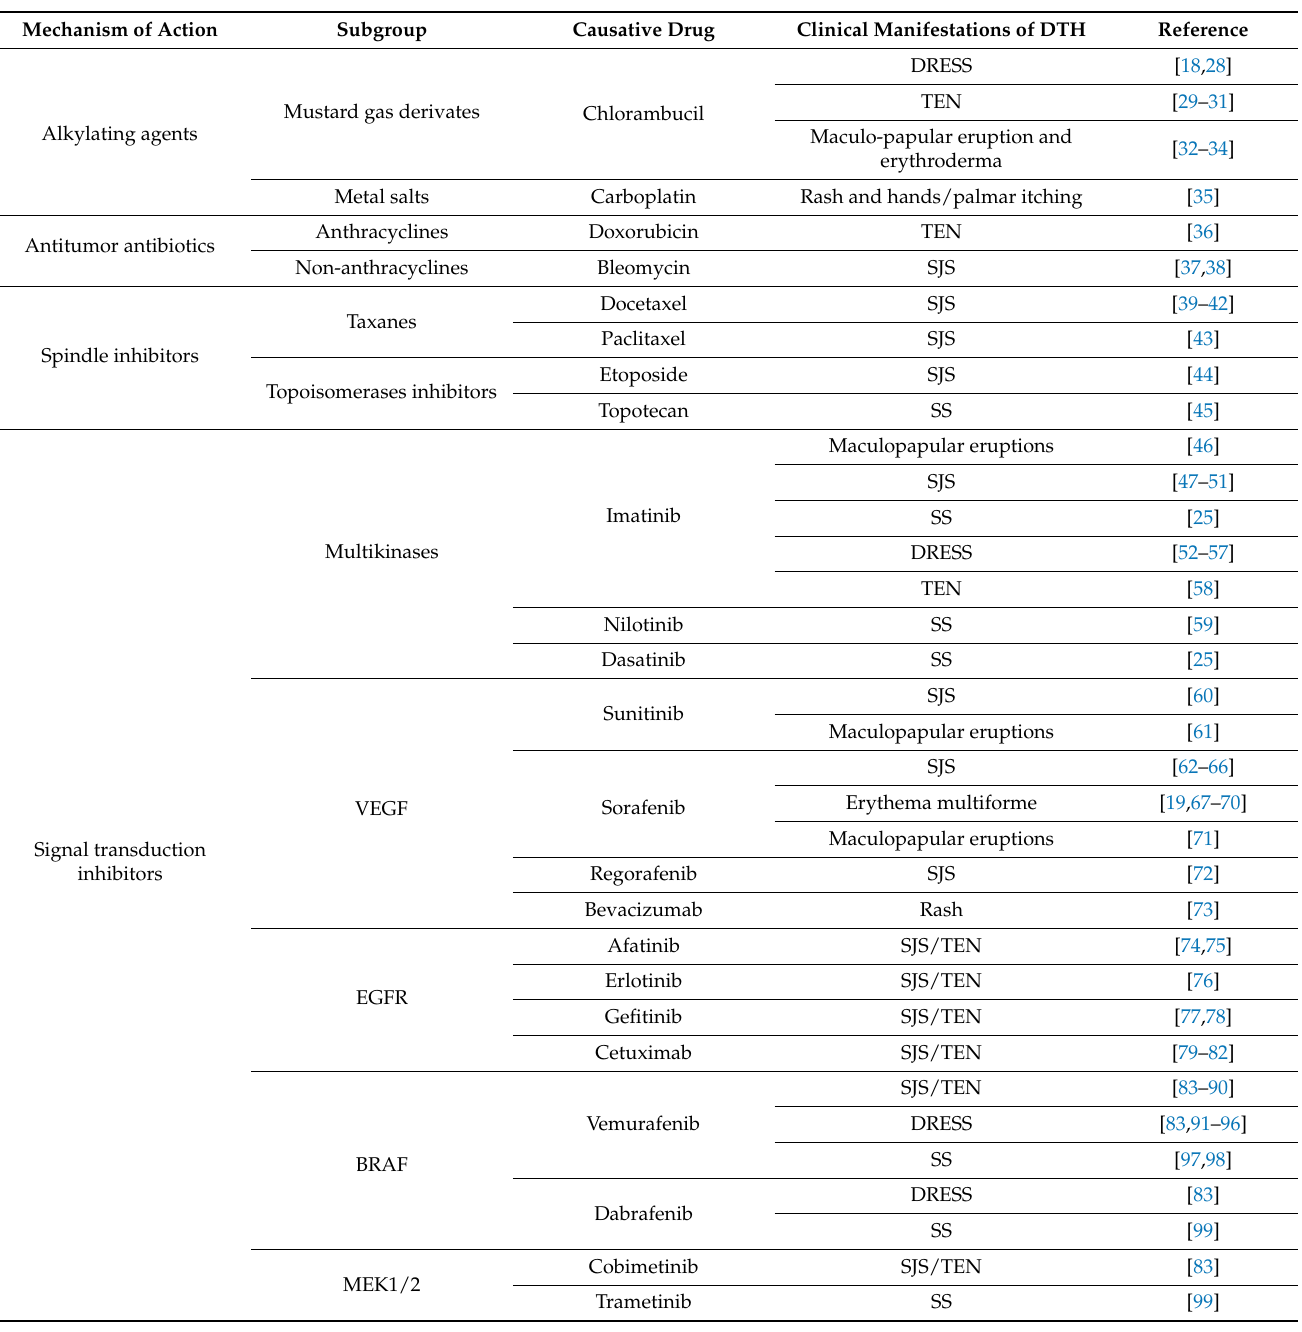
Table 2. Clinical manifestations of DTH related to antineoplastics